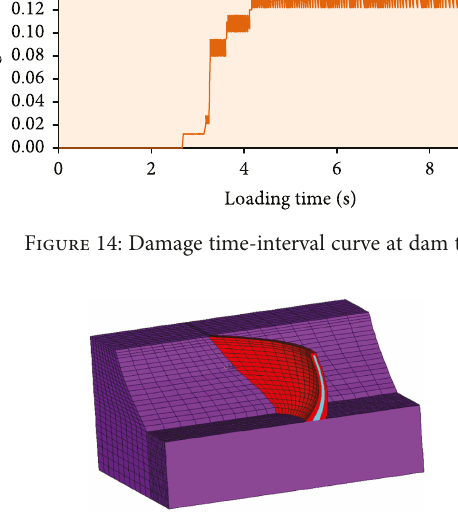
Figure 15: Finite element model of arch dam with reinforcement